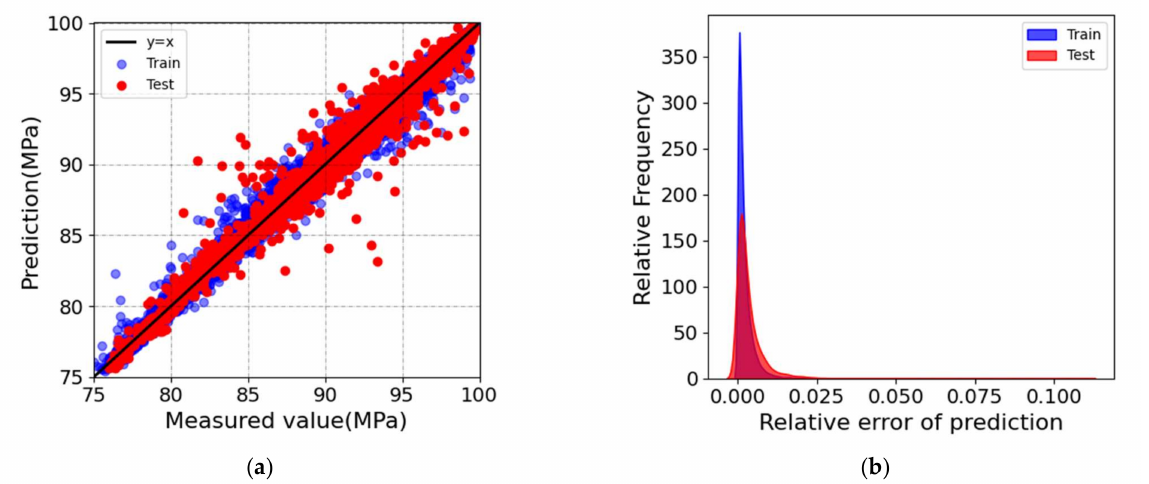
Figure 3. Regression analysis on the training dataset and the unseen test dataset by the trained XGBoost model. ( a ) The experimental measurement and the numerical prediction of the relative density. The solid line y = x is the identity line for reference. ( b ) Distribution plot of relative error for the training dataset and the unseen test